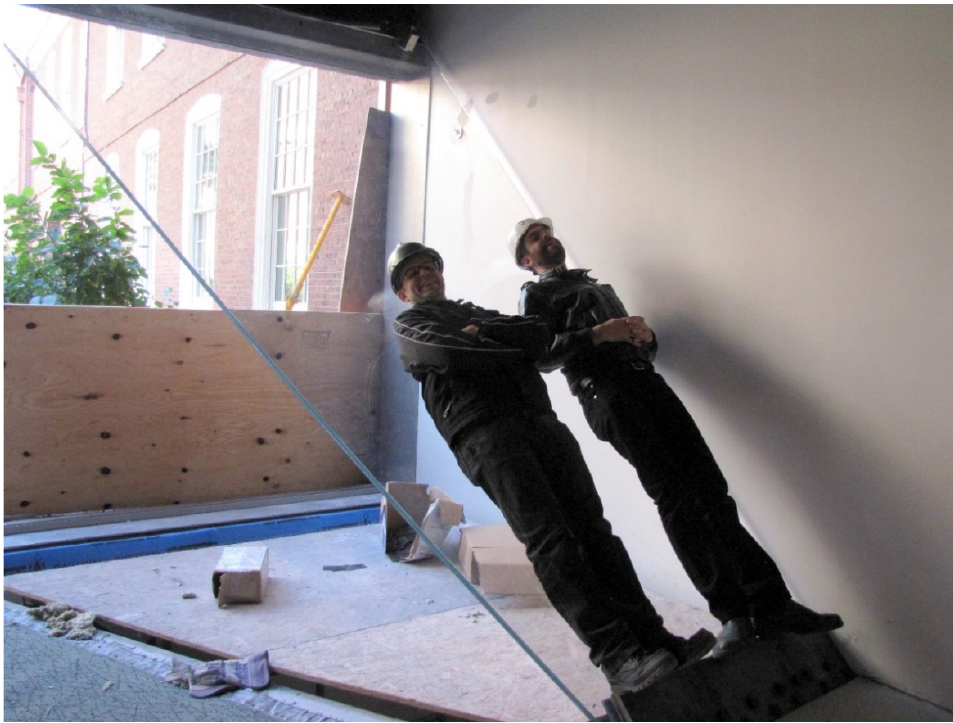
Fig. 10 P-131317, 2011 | Load testing of glass